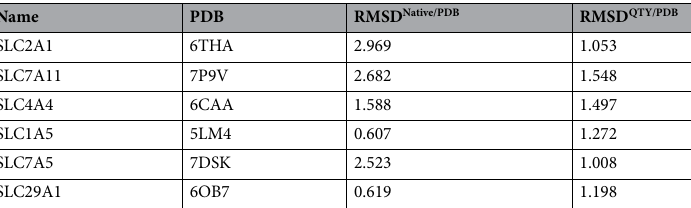
Table 3. RMSD between native solute carrier transporters, their water-soluble QTY variants, and crystal structures. Residue mean-square distance (RMSD) in Å, – = not applicable. All RMSD values are below 3 Å and show good superposition between structures. All models and scripts for structure preparation and superposition in PyMOL are presented in the GitHub repository: https:// github. com/ eva- smoro dina/ slc.